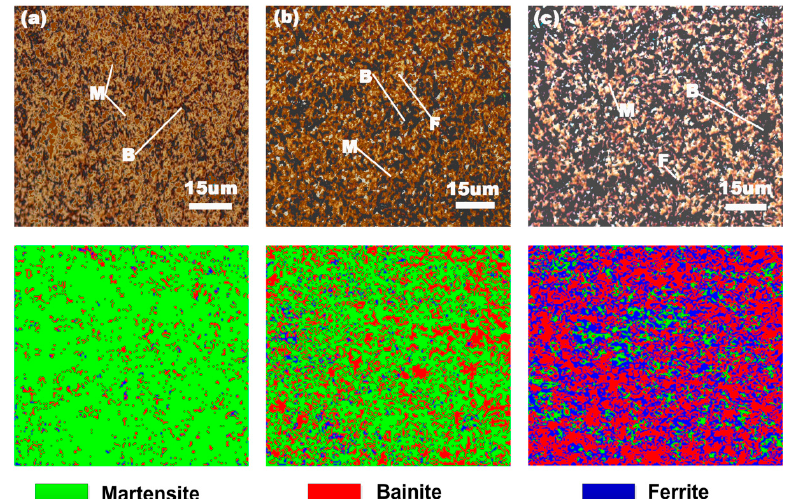
Figure 11. Various micrographs showing (from top to bottom) two-stage color tint etched optical micrographs, and the manually generated microstructure images at: ( a ) location C1 with a 300 °C die temperature, ( b ) location H1 with a 300 °C die temperature, and ( c ) location H1 with a 600 °C die temperature.